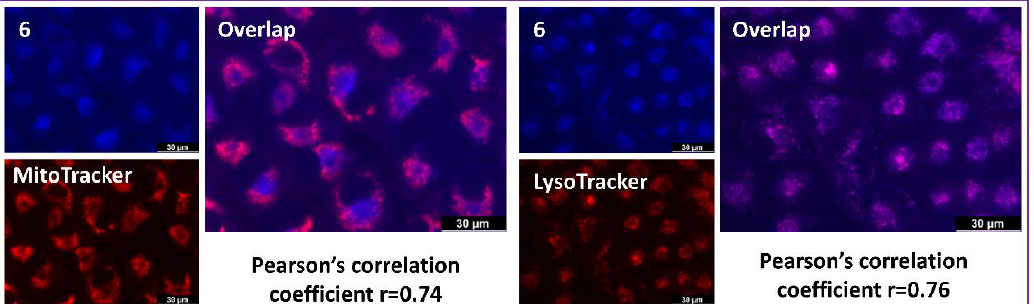
Figure 7. Intracellular localization of 6 (shown in blue) in A549 cells. Cells were treated with 10 µ M of the compound for 90 min at 37 ◦ C and co-localization with mitochondria (MitoTracker) or lysosomes (LysoTracker), all shown in red, was monitored by confocal microscopy. ( λ exc = 348 nm, λ em = 430–550 nm). Analysis was performed using ImageJ software and the appropriate JACoP plugin. Co-localization was assessed by the Pearson correlation